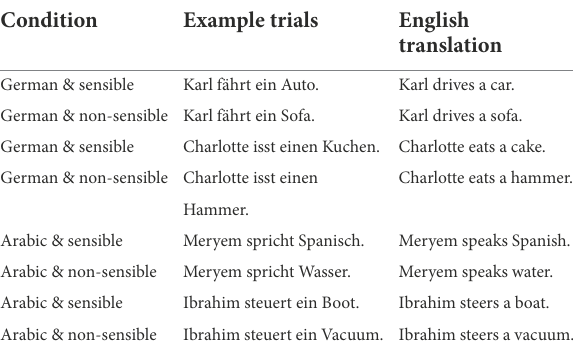
TABLE 1 List of example trials in the SJ